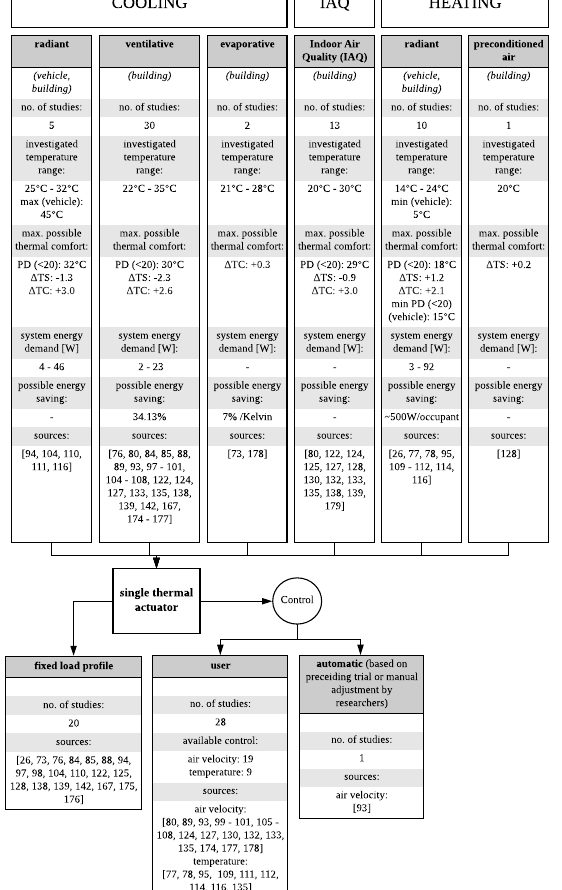
Figure A1. Summarizing chart of personalized climatization systems depending on heating and cooling method: single thermal